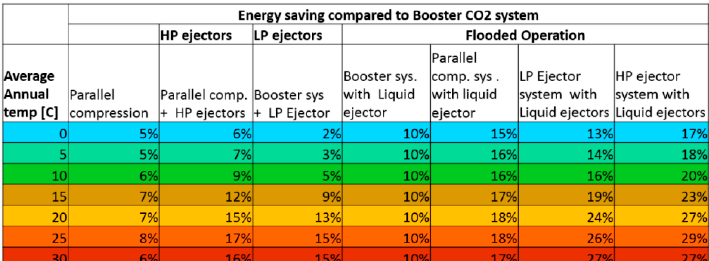
Figure 15. Energy saving of various transcritical R744 booster supermarket refrigeration systems at different average annual temperatures compared to a conventional transcritical R744 booster supermarket unit [53].